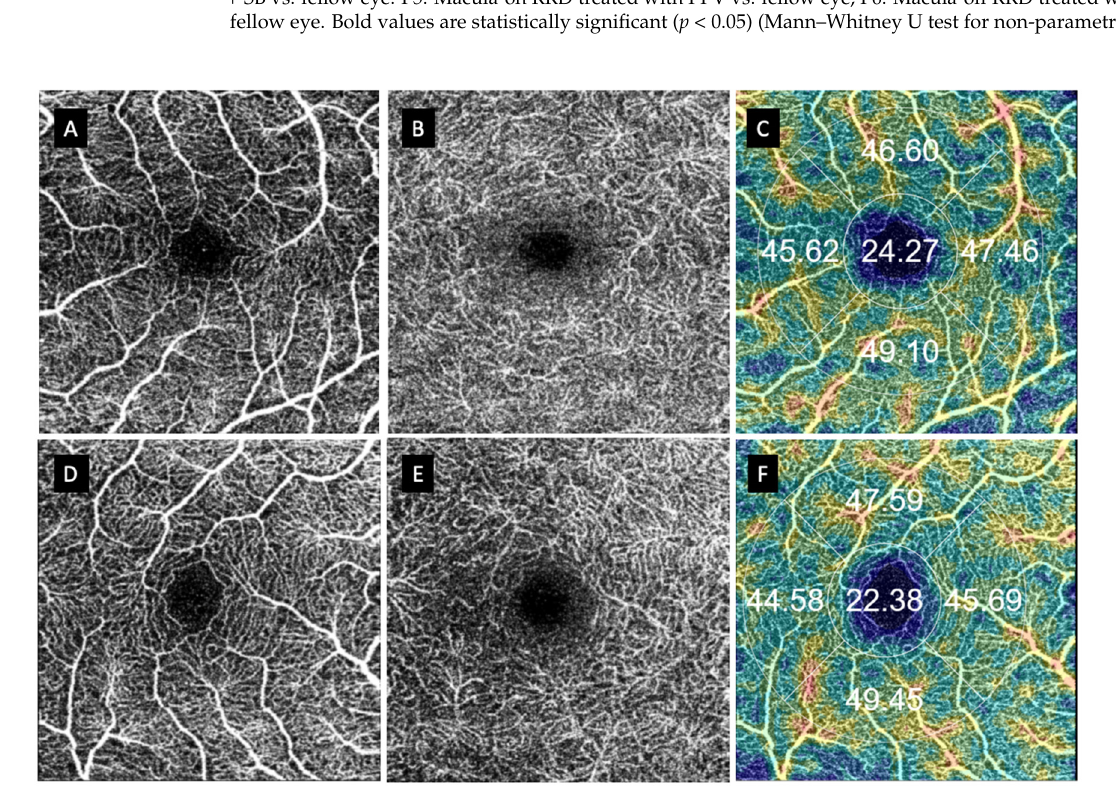
Figure 5. Anatomical finding in patients with macula-off RDD vs. their fellow eyes. ( A – C ) Macula- on RDD. ( D – F ) Contralateral healthy eye. ( A , D ) represent superficial capillary plexus (SCP); ( B,E ) represents deep capillary plexus; and ( C , F ) represents vessel density in the SCP.